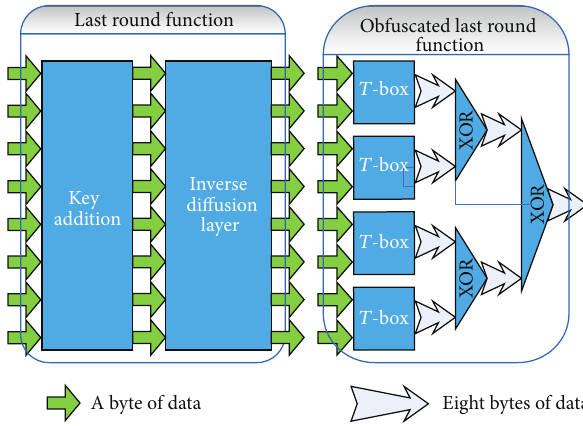
Figure 3: Data flow of the standard and the obfuscated implemen- tation of round